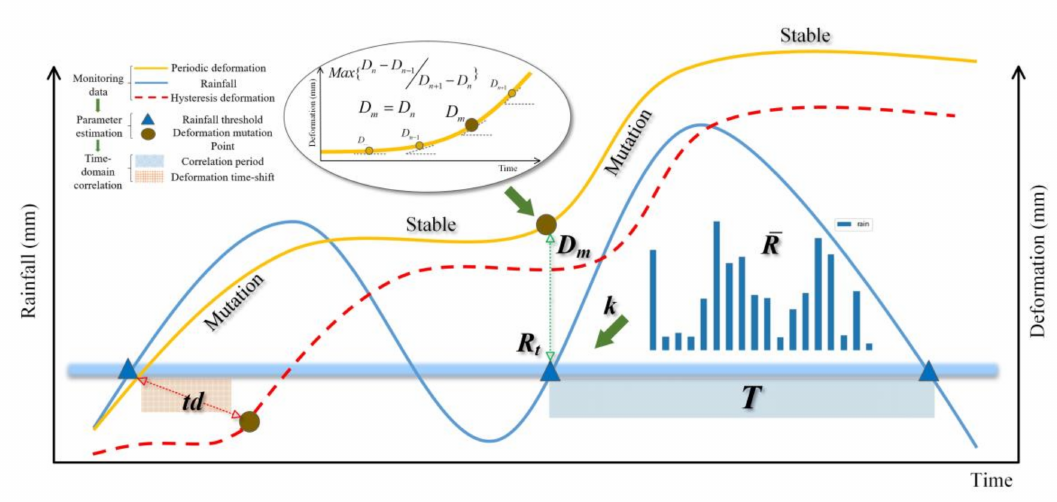
Figure 3. Conceptual diagram of regional rainfall-induced landslide deformation time-domain correlation measurement. The figure clearly shows the landslide monitoring data, including the periodic deformation curve (yellow), the hysteresis deformation curve (red), and the regional rainfall curve